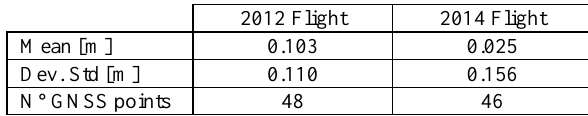
Table 2. Statistics of the comparison between the GNSS elevation data and the photogrammetric reconstructed DSM for the two flights.